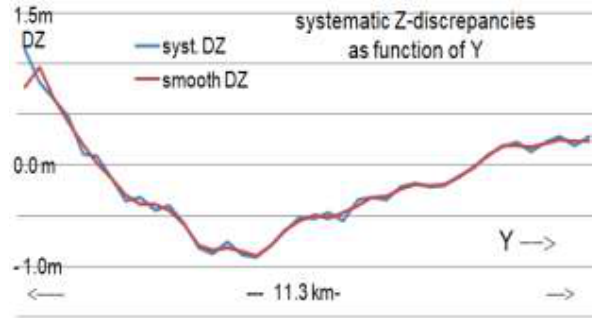
Figure 18. Systematic Z-discrepancies of Kompsat-3 DSM as function of Y